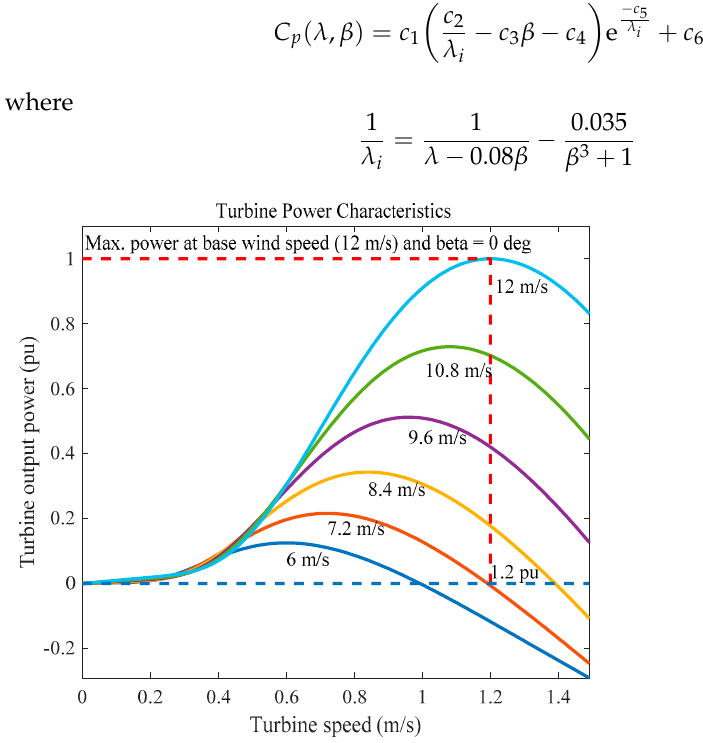
Figure 6. The turbine power characteristics curve.